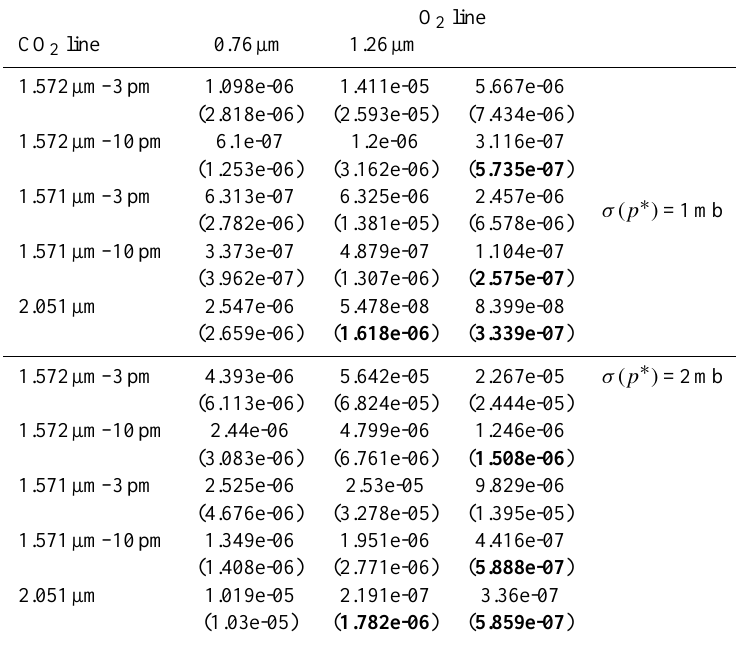
Table 2. Surface pressure relative uncertainty for (cid:49)τ CO for σ (cid:49)ξ (h) were computed using Eqs. (A5–A6) and σ(p ∗ ) =1mb and σ(p ∗ ) =2mb. The values in parentheses are the values from Table 1 added to the surface pressure relative uncertainties, and boldfaced values indicate instrument configurations for which an O 2 lidar with enough precision could provide more information than the CO 2 only configuration with NWP p ∗ . Relative uncertainties are σ 2 (cid:16) (cid:49)τ (cid:17) CO2 (cid:49)τ 2 and σ 2 . All computations assume constant profiles of 400ppm of CO 2 and 21% of O 2 p ∗ (cid:49)τ O2 O 2